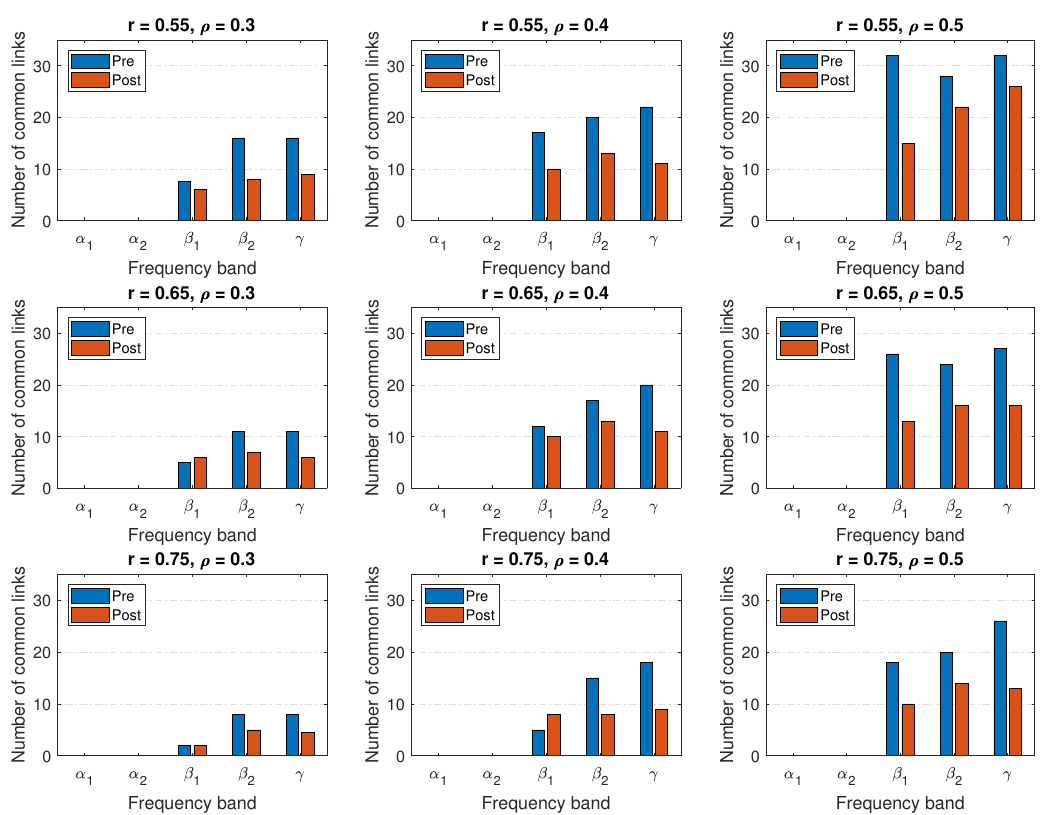
Figure 3. Number of functional links in the group’s adjacency matrix, G ( ρ , r ) . Threshold values indicate the persistence of functional links among the recordings’ time ( r ) and their strength ( ρ ), and they were set at ρ = 0.30,0.40,0.50 and r = 0.55,0.65,0.75. Pre- and post-intervention data are displayed as blue and red bars,